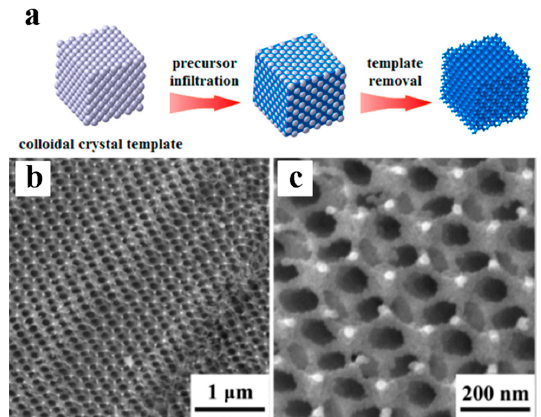
Figure 5. Schematic illustration of the experimental procedure ( a ) and SEM images of the Figure 5. three-dimensionally-ordered macroporous (3DOM) In-ZnO structures ( b – c ) (Reproduced with three-dimensionally-ordered macroporous (3DOM) In-ZnO structures ( b , c ) (Reproduced permission from [54], Copyright 2016, American Chemical Society).